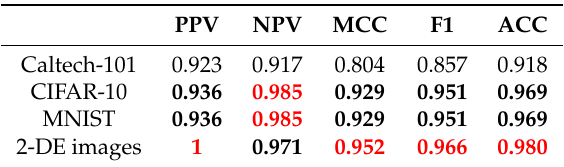
Table 5. Performance of our method in different source tasks. The red bold is the best performance of each evaluation. The black bold is the second best performance. PPV NPV MCC